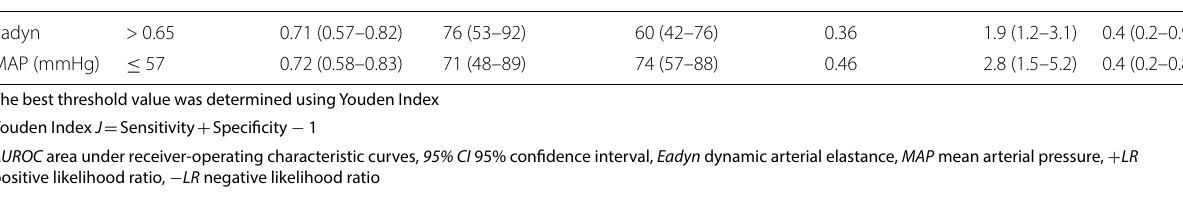
10% after infusion of 250 ml saline over 10 min ≥